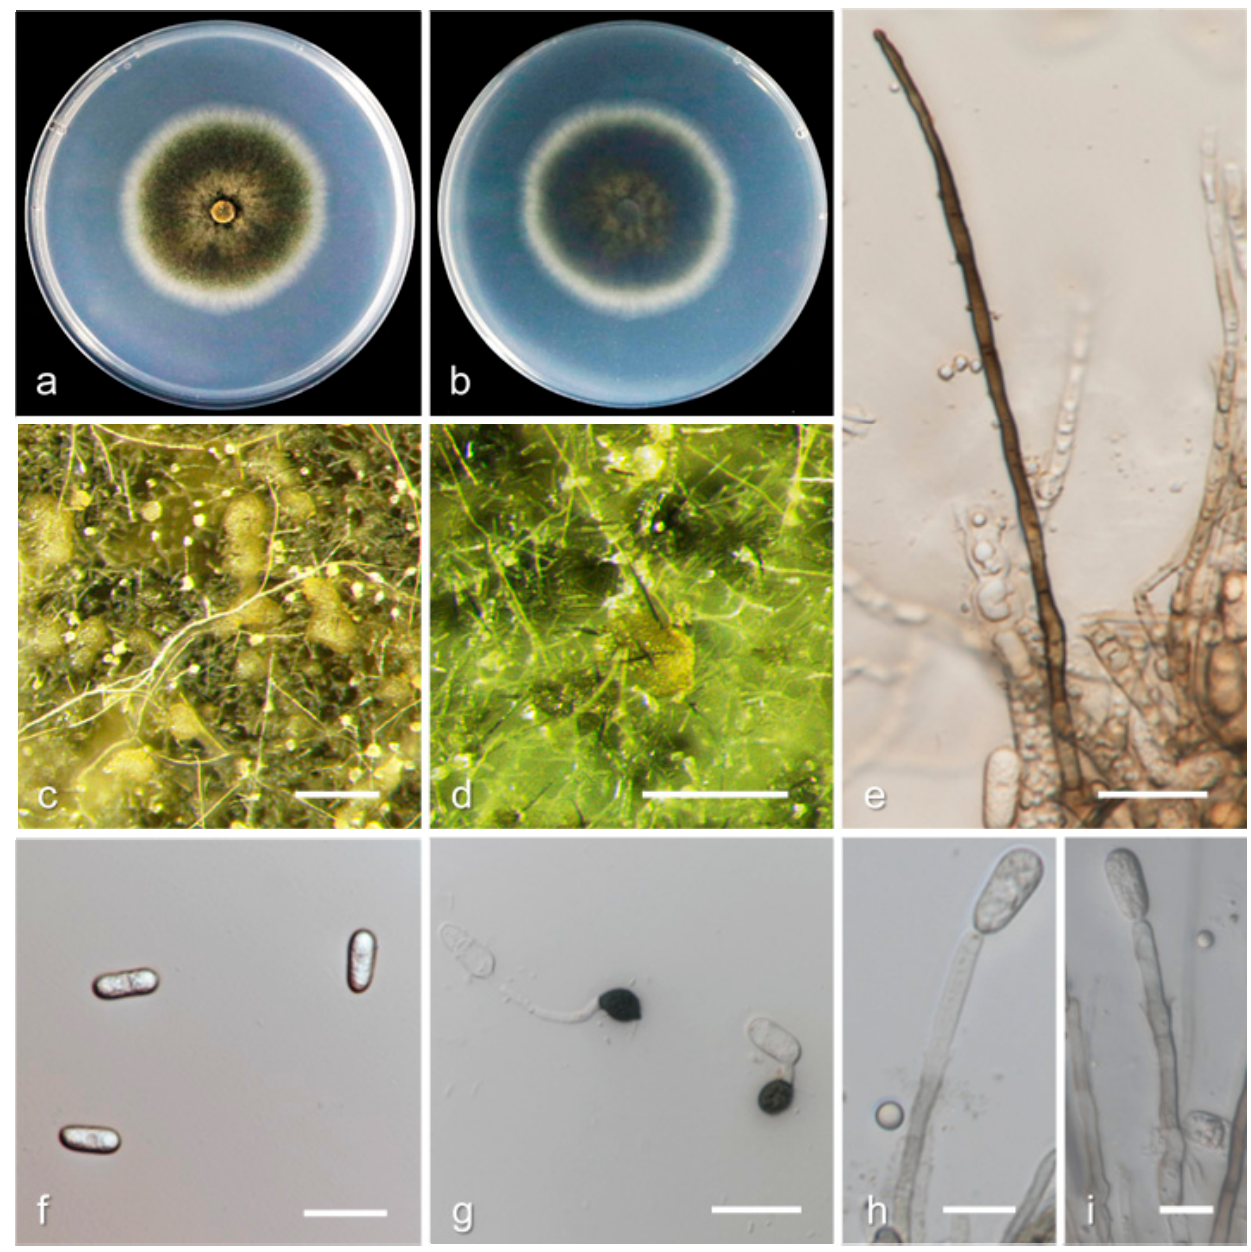
Figure 14. Biological characteristics of Colletotrichum folicola . ( a , b ) Front and back view of six-day-old PDA culture; ( c , d ) conidiomata; ( e ) setae; ( f ) conidia; ( g ) appressoria; ( h ) conidiophores (( a – h ) isolate YNHH 10-1). Scale bars: ( c , d ) = 200 µ m; ( e – g ) = 20 µ m; ( h , i ) = 10 µ m. MycoBank Number: